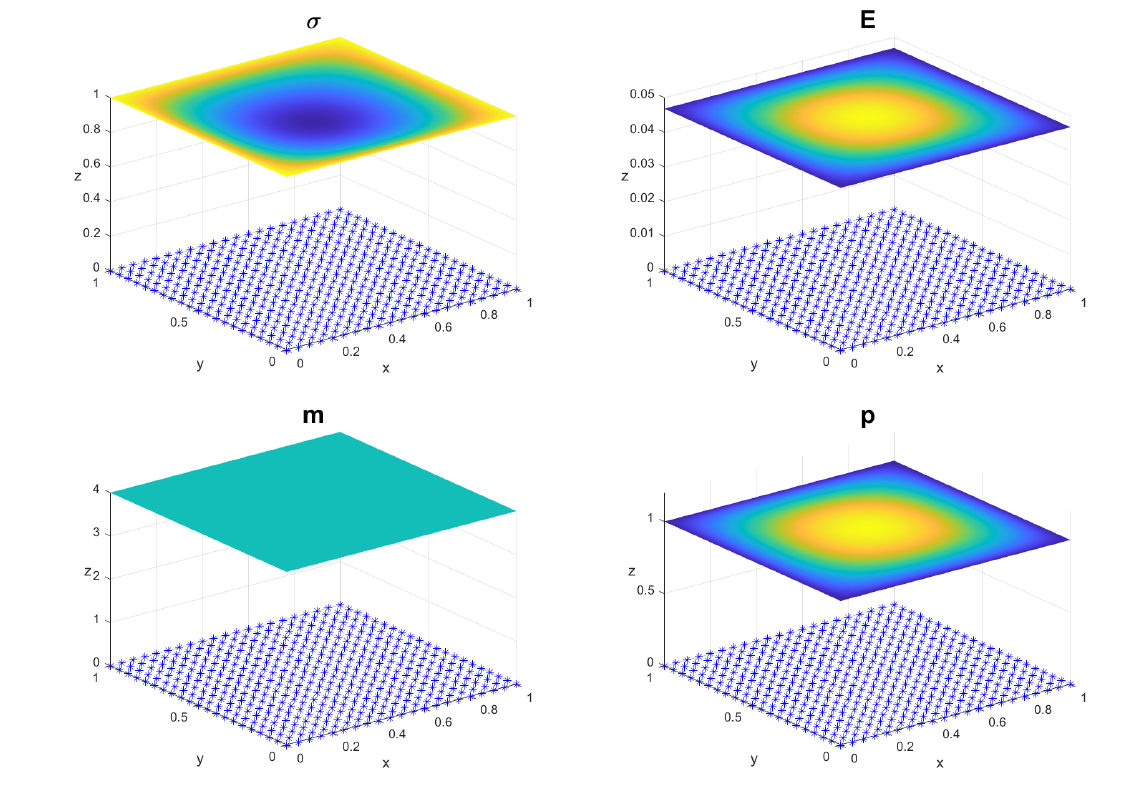
Figure 4. Graphs of the functions: σ , E , m and p for t = 10 s.